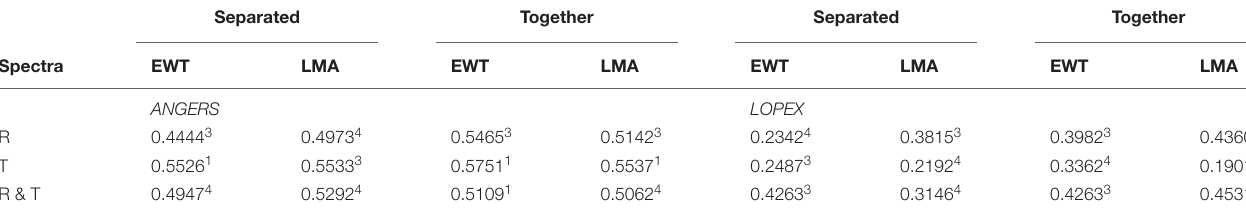
TABLE 4 | The optimal R 2 of ANN models for EWT and LMA analysis by using 753 R, T, and R&T spectral bands respectively. Separated Together Separated Together